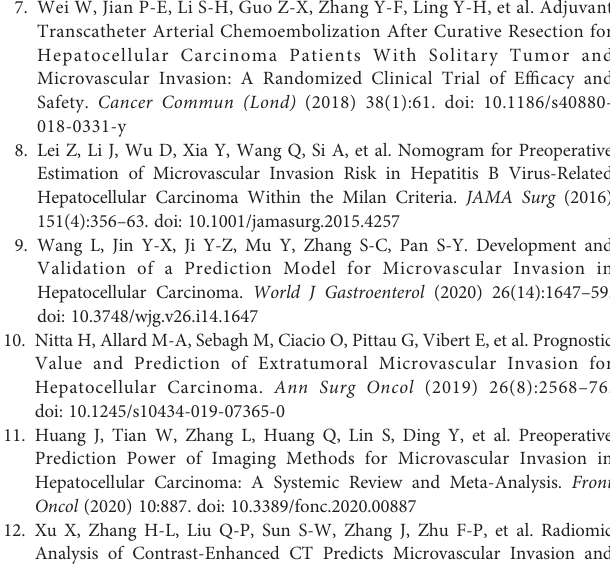
A bounding box according to the union of annotations (Green line). Extension of the bounding box (Blue line). Supplementary Figure 2 | Survival curves of histologic microvascular invasion (MVI) and predicted MVI of the three models in validation group (n=102). (A) Overall survival (OS) curves. (B) Recurrence-free survival (RFS) curves. Comparisons between curves were performed with the log-rank test. CEUS-DCNN: CEUS video- based deep convolution neural network model. CECL-DCNN: clinical parameter combining CEUS-based deep convolution neural network